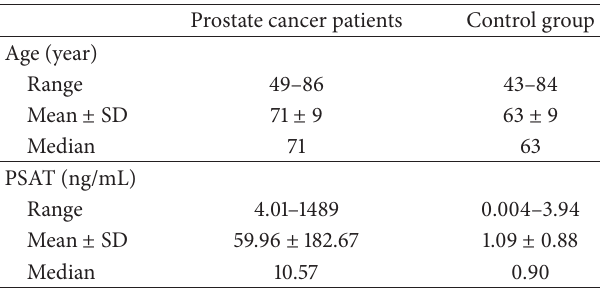
Table 1: Clinical characteristic of studied